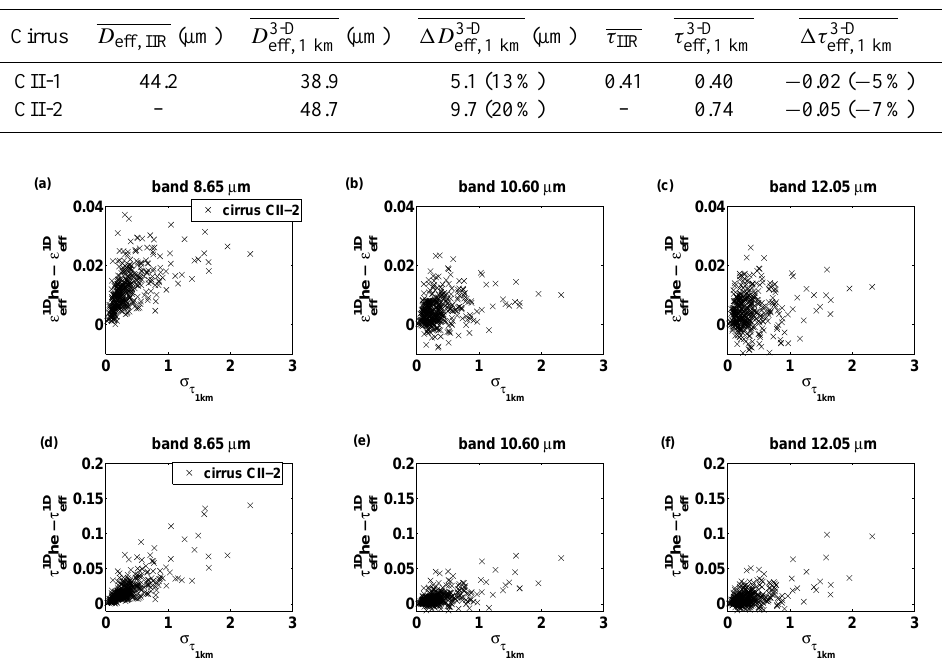
Figure 11. Effective emissivity differences ( a , b , c ) between ε 1-D τ 1-D he and τ 1-D retrieved from radiances calculated in the case of vertically heterogeneous and vertically homogeneous cloudy columns, eff eff respectively, as a function of the standard deviation of the optical thickness σ τ